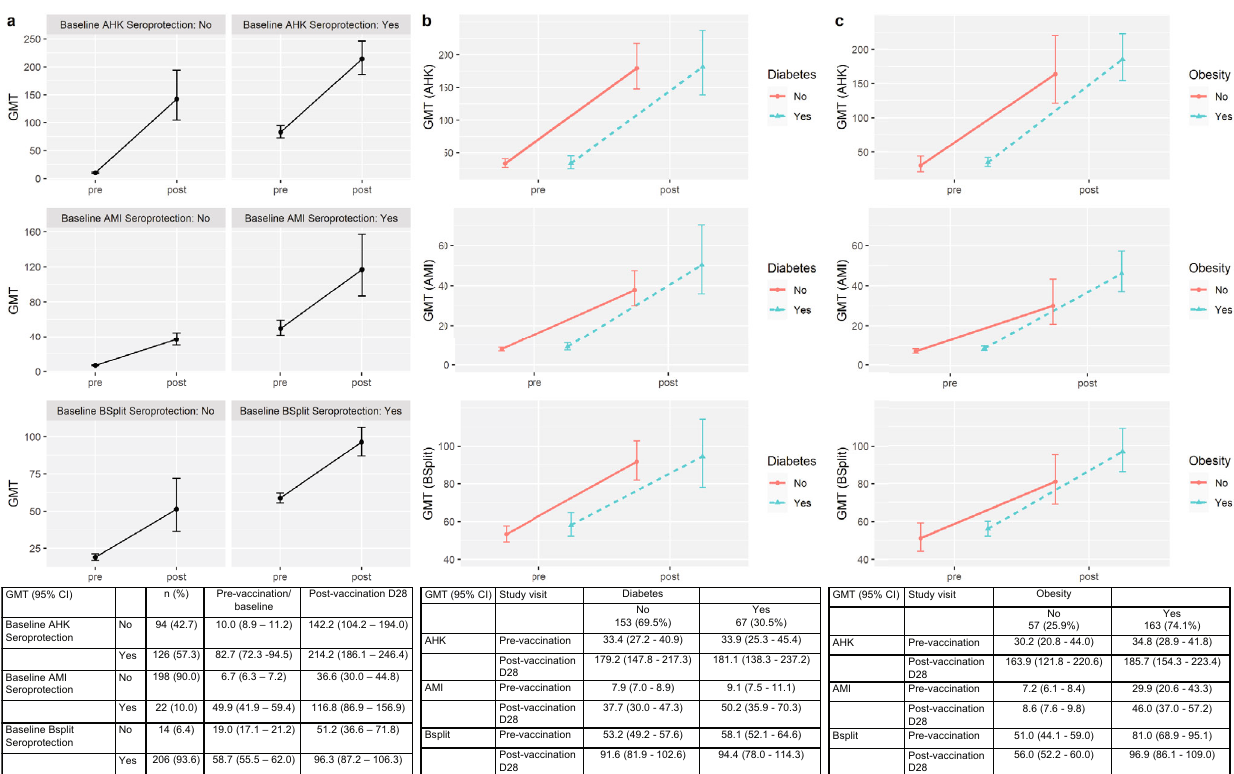
Fig. 2 Geometric mean titers (GMT) pre-and post-in fl uenza vaccine among full cohort for in fl uenza A/HK/H3N2, A/MI/H1N1, and B-split, and among those with and without diabetes mellitus and obesity. Panels a shows line graphs depicting GMT and 95% con fi dence intervals pre- and post-in fl uenza vaccination for A/HK/H3N2, A/MI/H1N1 and B-split for the full cohort, subcategorized by their baseline seroprotection status (HAI of at least 1:40) for each respective strain. Panels b shows GMT and 95% con fi dence intervals pre- and post-in fl uenza vaccination for the three strains amongst those with diabetes mellitus ( n = 67) compared to those without. Panels c show GMT and 95% con fi dence intervals pre-and post-in fl uenza vaccination for the three strains amongst those with obesity ( n = 163, applying the same de fi nition as in Tables 1 and 2) compared to those without. The embedded table displays the GMT and 95% CI data as shown in the corresponding panel line